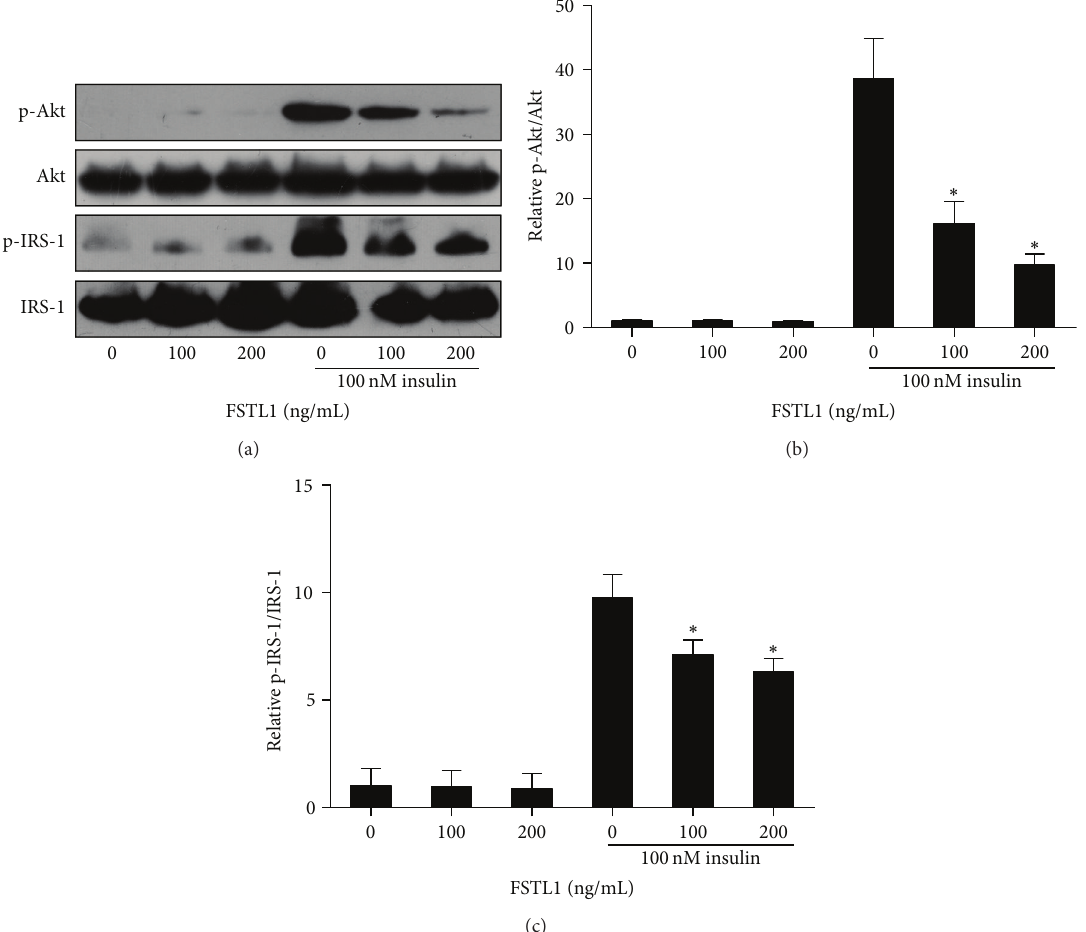
Figure8:RecombinantFSTL1inhibitsinsulinsignalingin3T3-L1adipocytes.Differentiated3T3-L1adipocytesweretreatedwithrecombinant mouse FSTL1 (100 or 200 ng/mL) or vehicle for 24 h and subsequently stimulated with 100nM insulin for 10min. (a) Phosphorylation of Akt (Ser473) and IRS-1 (Tyr612) was assessed by Western blot analysis. (b) and (c) Intensity of bands was quantified by densitometry and expressed as ratio of phosphorylated to total protein. The ratio was normalized to control. Data are mean ± SE; 𝑛 = 3 . ∗ 𝑃 < 0.05 versus cells only stimulated with